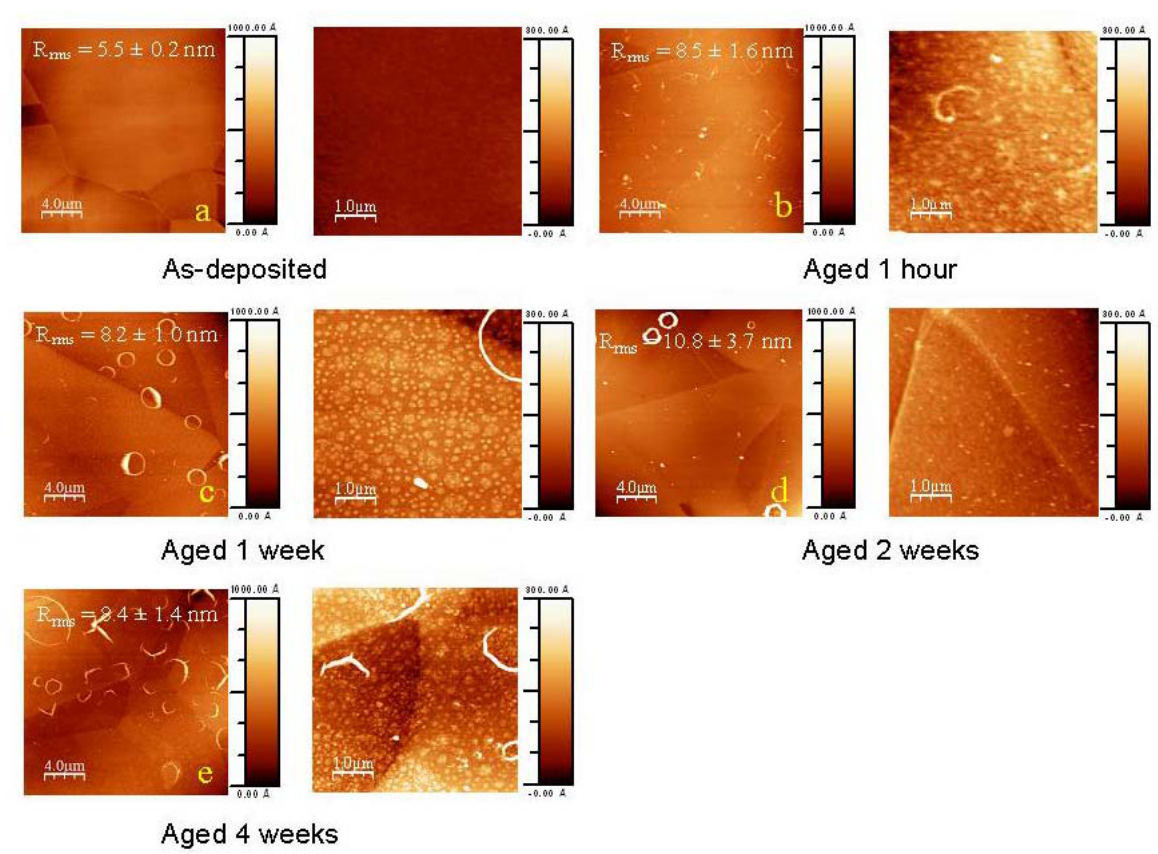
Figure 1. Tapping mode AFM micrographs 20 × 20 μ m 2 for flat samples at different time points of ageing: (a) as-deposited, (b) aged 1 hour, (c) aged 1 week, (d) aged 2 weeks, (e) aged 4 weeks and zoom 5 × 5 μ m 2 of each.